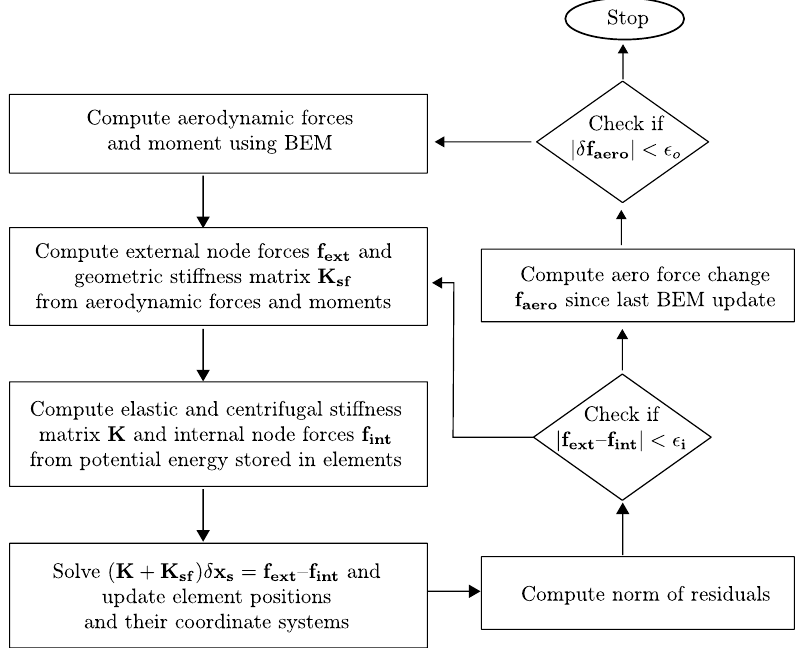
Figure 5. HAWCStab2 steady state analysis flow chart. (cid:101) i and (cid:101) o are convergence criteria for the inner and outer loops of the steady state